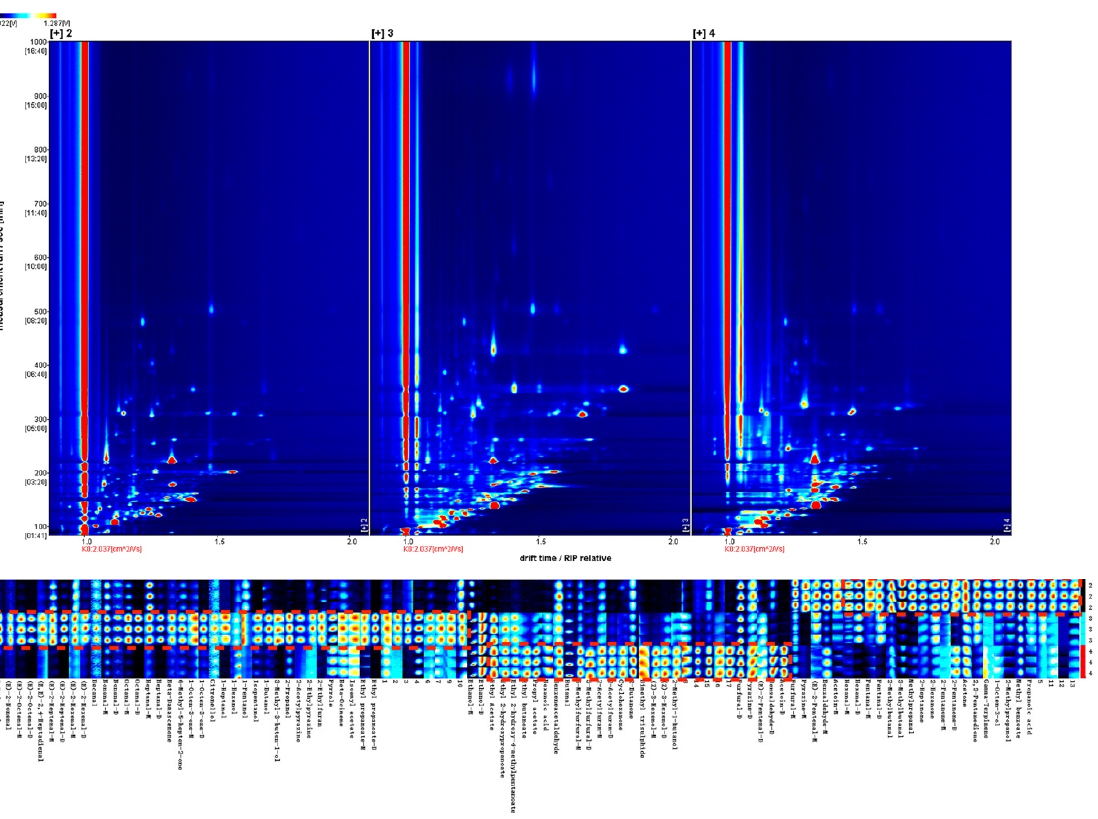
Figure 2. HS-GC-IMS topographic plots ( top panel ) and gallery plot fingerprints ( bottom panel ) of volatile flavor compounds in samples from groups #2, #3, and #4. Top panel in left to right and bottom panel in top-down order.